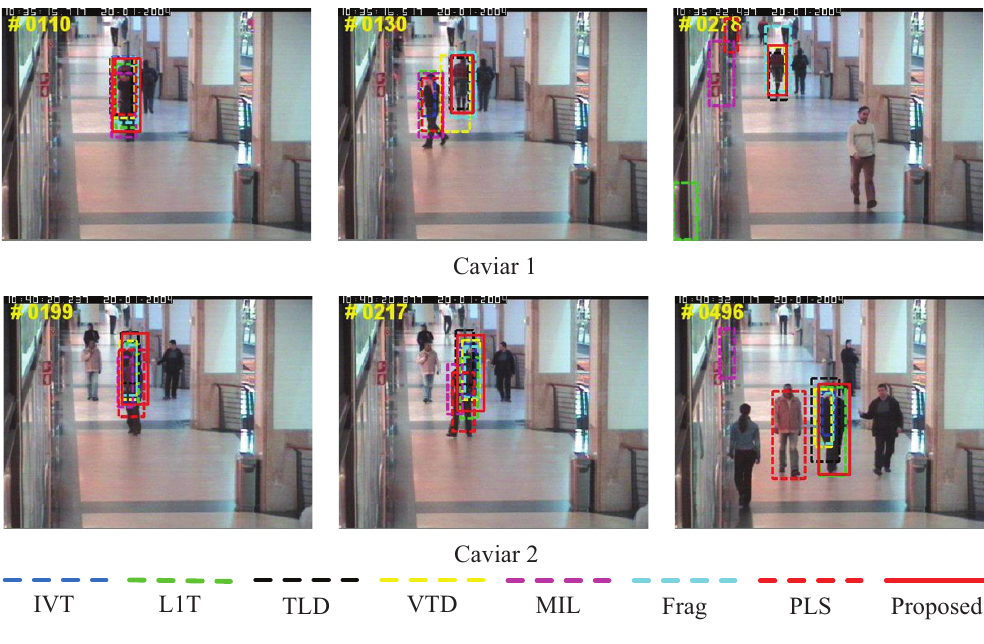
Figure 6. Qualitative evaluation results of eight algorithms on challenging tested sequences Caviar 1 and Caviar 2